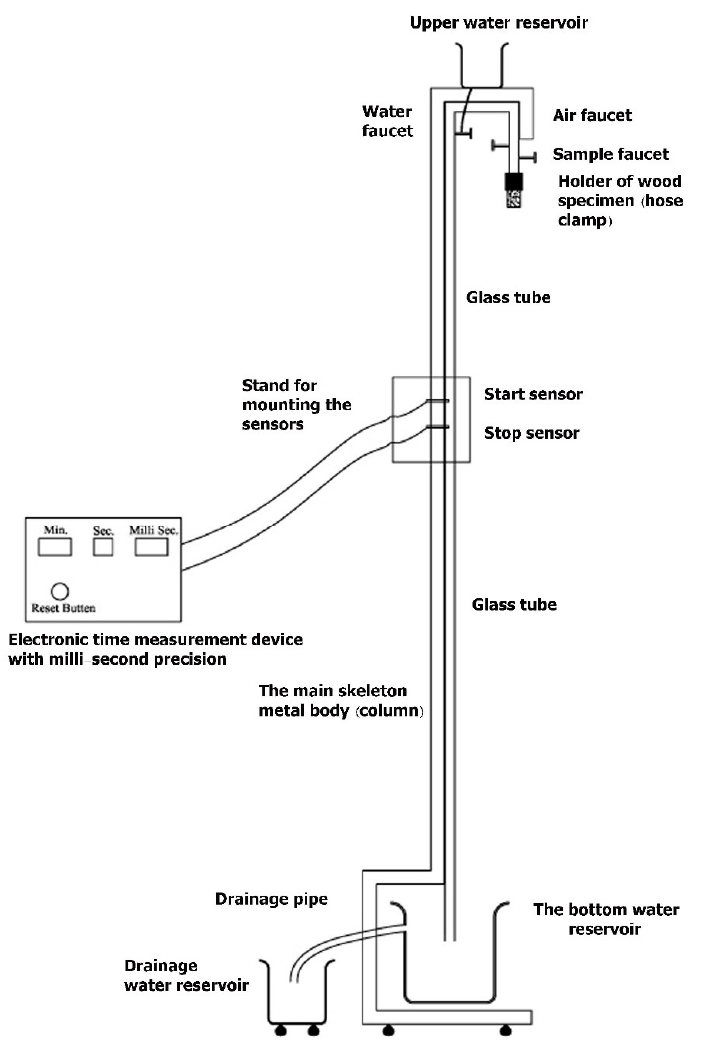
Figure 1. Schematic of the specific gas permeability measurement apparatus, equipped with a single- phase electronic time measurement device with milli-second precision (approved under certificate No. 47022; issued by The Iranian Research Organization for Scientific and Technology) [10,13].